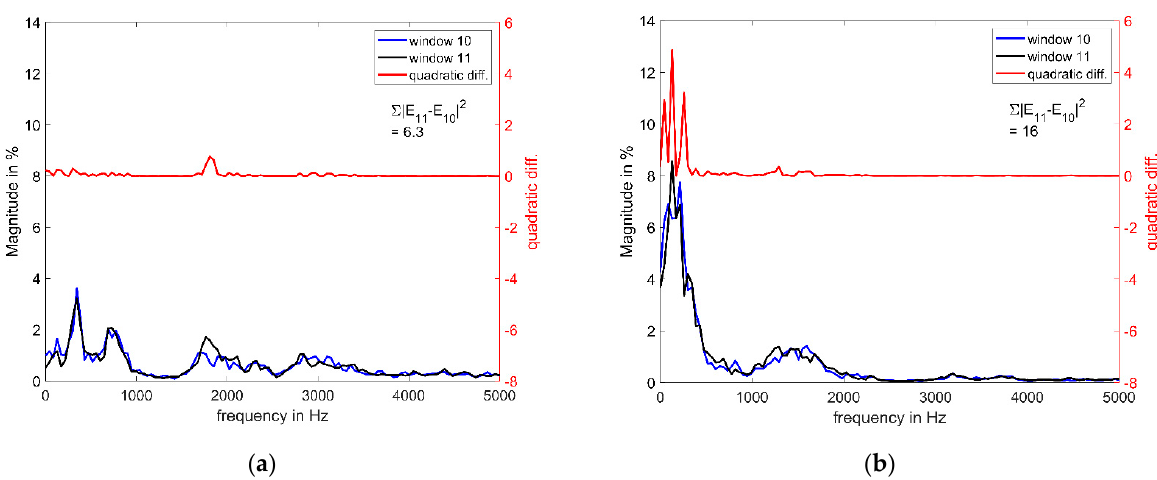
Figure 7. Averaged magnitude of 10 squeals of pig 3 ( a ) before and ( b ) after surgery for two neighboring consecutive windows. The red line is the quadratic difference between both windows at each x-axis position. Magnitude spectra were calculated using 1024 data point windows with 50% overlap. Flux is higher after surgery, as it measures the quadratic difference between % magnitude; i.e., a single high deviation results in a larger total deviation than multiple small ones.